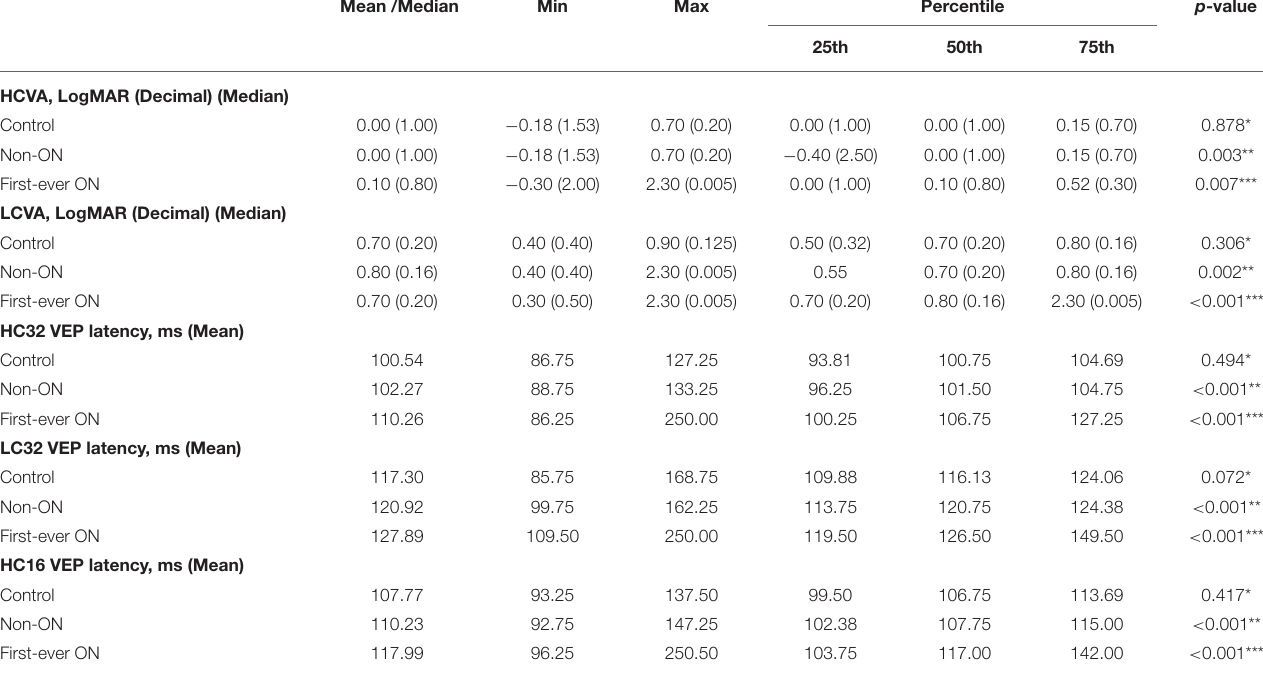
TABLE 2 | The value of Visual acuity and VEP latency between high-contrast and low-contrast. Mean /Median Min Max Percentile p -value 25th 50th 75th